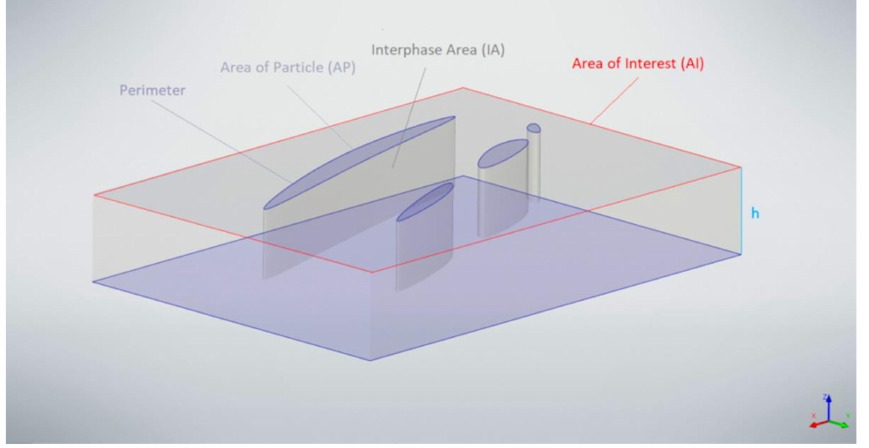
Figure 6. Particle morphology model describing the terms necessary for the